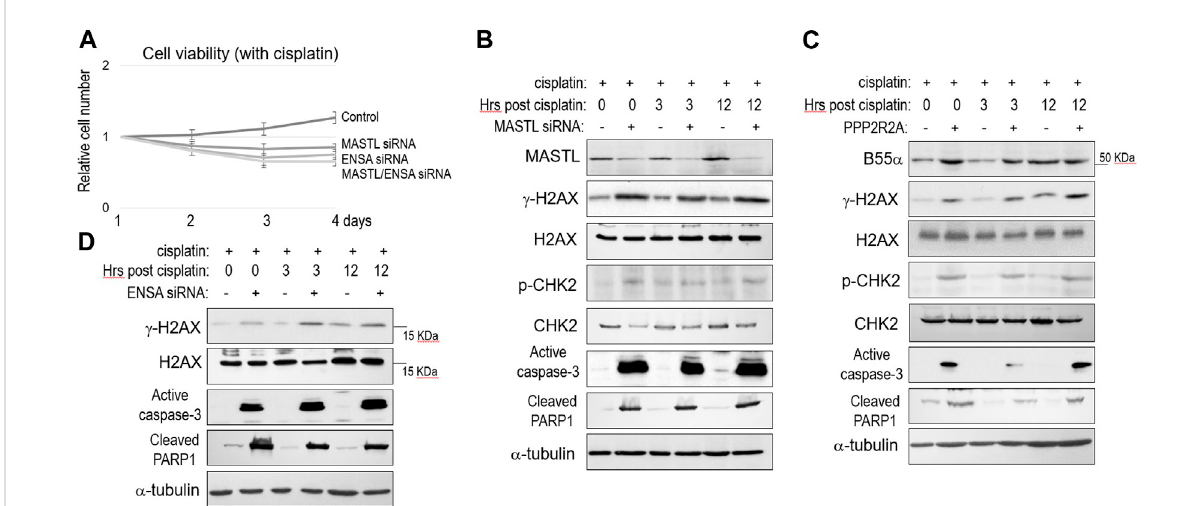
FIGURE 3 The MASTL-ENSA/ARPP19-PP2A/B55 pathway modulates the cisplatin response in OSCC. (A) Cell viability assay was performed as in Materials and Methods. SCC38 cells with or without MASTL or ENSA siRNA were incubated with cisplatin (3.3 μ M) from day 1. The cell numbers at days 2 – 4 were normalized to that at day 1 (untreated). The mean values and standard derivations, from three independent experiments, were shown. (B) SCC38 cells with or without MASTL siRNA were treated with cisplatin (5 μ M) for 2 h, and allowed for recovery for the indicated numbers of hours. Cells were harvested and analyzed by immunoblotting, using the indicated antibodies. (C) SCC38 cells with or without HA-PPP2R2A expressionweretreatedwithcisplatin(5 μ M)for2 h,andallowedforrecoveryfortheindicatednumbersofhours.Cellswereharvestedandanalyzed by immunoblotting, using the indicated antibodies. (D) SCC38 cells with or without ENSA siRNA were treated with cisplatin (5 μ M) for 2 h, and allowed for recovery for the indicated numbers of hours. Cells were harvested and analyzed by immunoblotting, using the indicated antibodies.